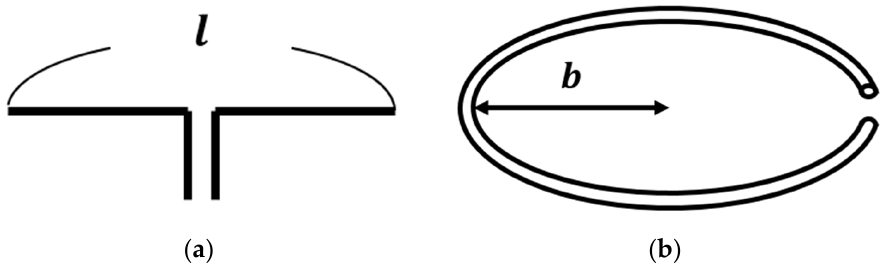
Figure 9. Antenna candidates: ( a ) dipole antenna and ( b ) circular loop antenna.